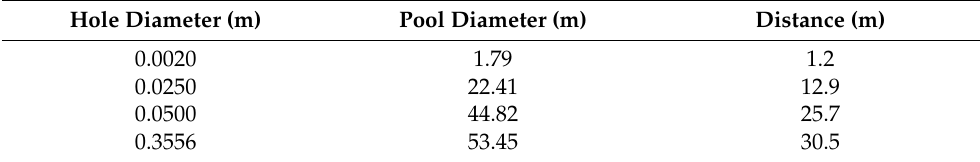
Table 6. Pool diameter and distance at 37.5 kW/m 2 for each failure size scenario.